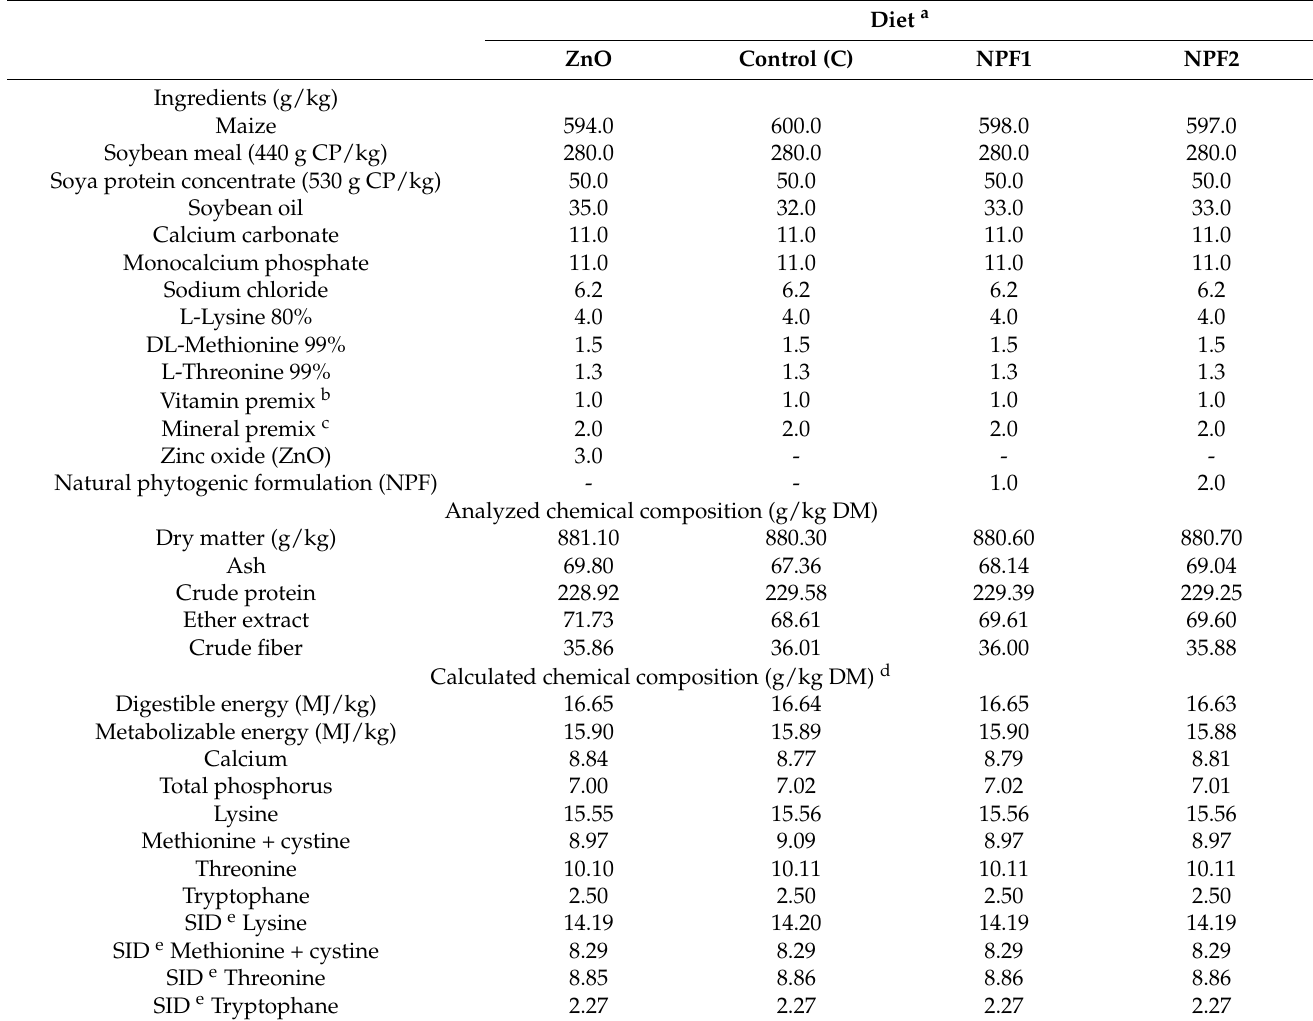
Table 1. Ingredient and chemical composition of the experimental